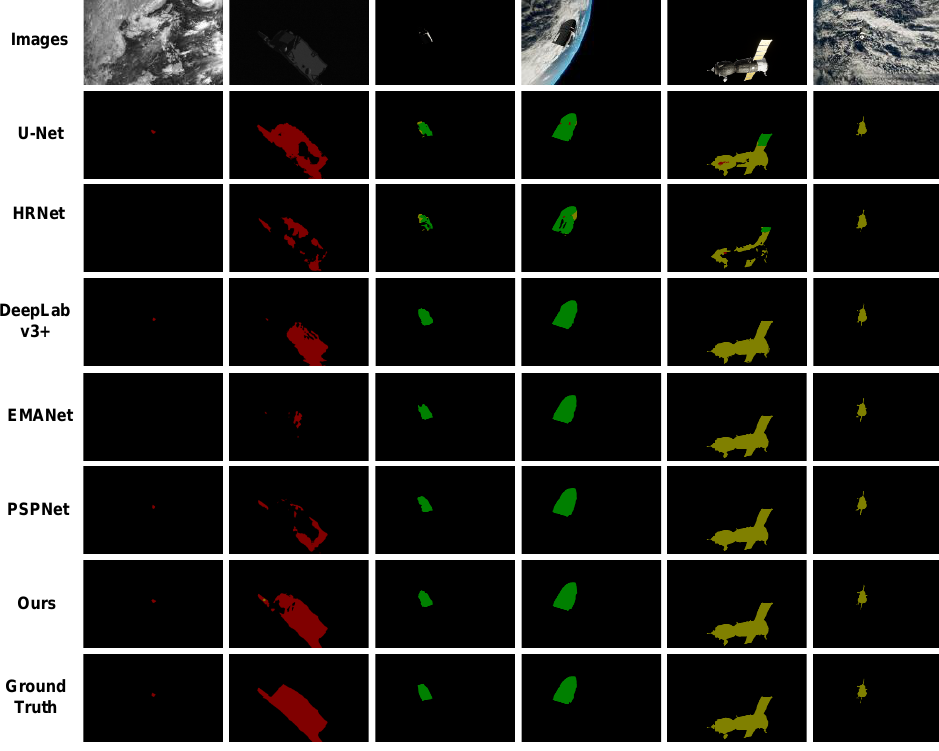
Figure 12. Experimental results and comparison with other methods.